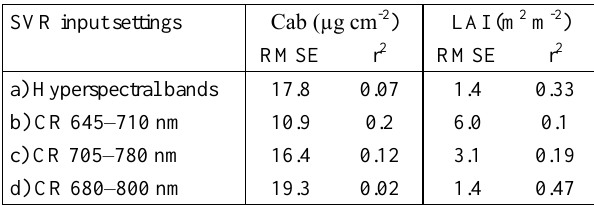
Table 4. Performance of SVR machines for retrievals of chlorophyll content (Cab) and leaf area index (LAI) of the beech forest site from airborne hyperspectral images